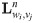
Schematic example of a subproblem of the proposed algorithm.(A) Example subproblem Lwi,vjn: At the n
th algorithmic step, we search for all paths of weight w
i leading to node v
j; (B) Finding a solution for the current subproblem by investigating solutions to prior subproblems: We investigate all predecessors v
p of the current node v
j; if there exists a solution to Lwp,vpM, i.e., there is a solution to the prior subproblem vs⇝wpvp of finding a path of weight w
p leading from v
s to v
p, and w
p + w
(vp, vj) = w
i, we find a solution to the current subproblem Lwi,vjn.